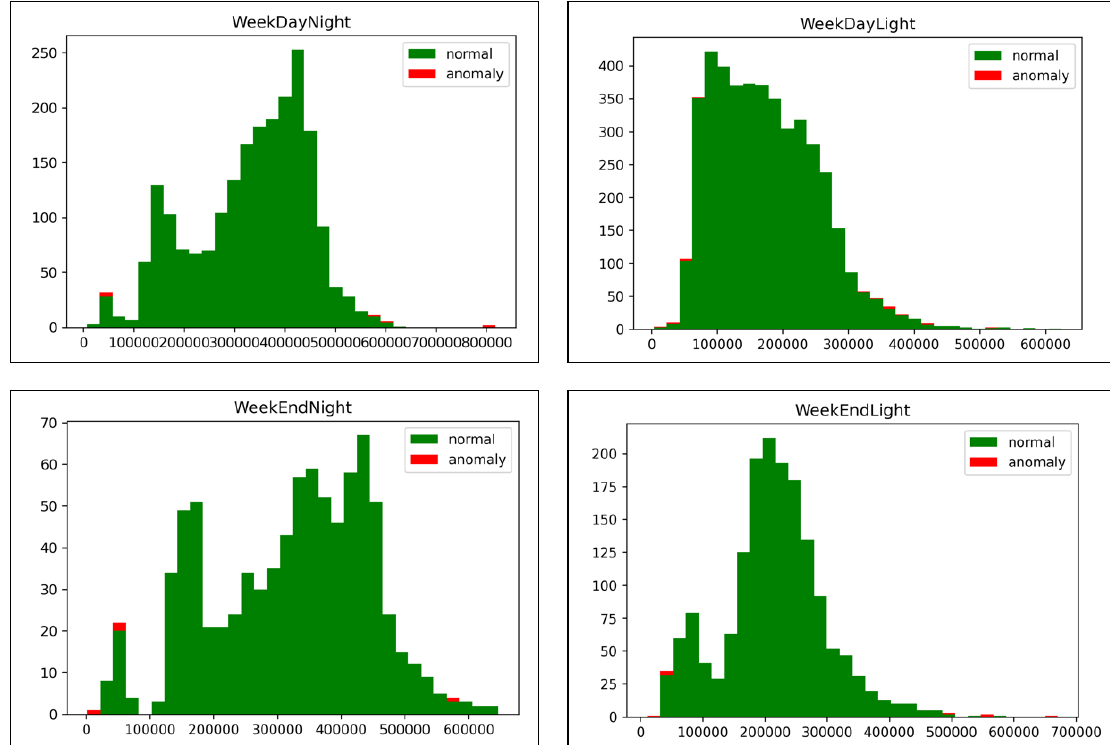
Figure 10. Plot frequency of normal and anomaly data detected by LOF.